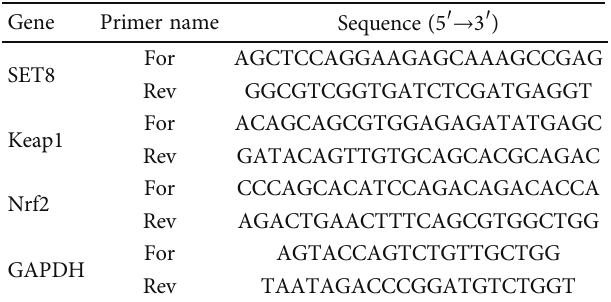
Table 1: Gene primer